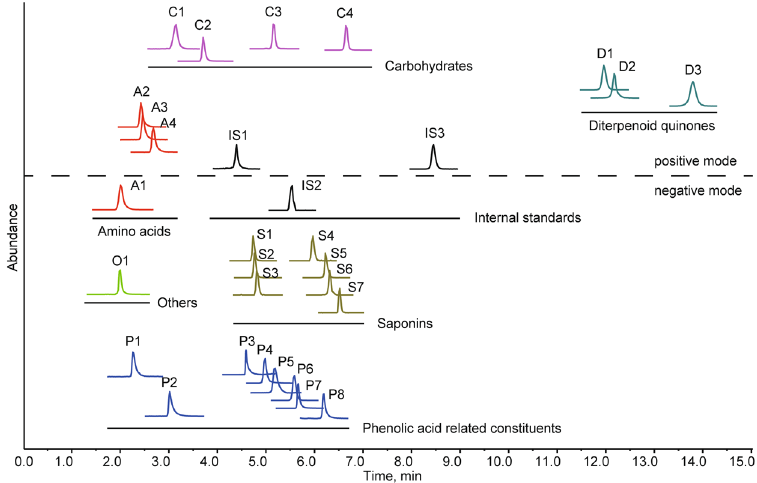
Figure 5. The MRM chromatograms of 27 analytes in Dan-Qi pair extract and three internal